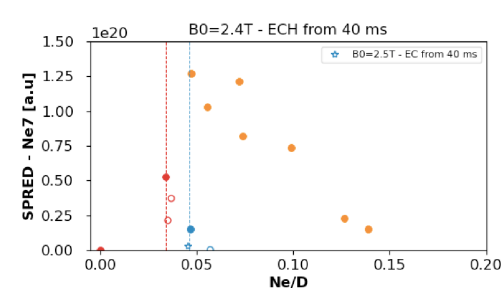
Figure 5. As the Ne / D increases, the integral of NeVII calculated from SPRED in the range 40-70 ms decreases. Power thresholds are (red) Ohmic: Ne < 3.5%, (Blue) EC 0.7 MW: Ne < 4.7%, (Orange) EC 1.4 MW: Ne up to 14%. Hollow circles correspond to failure.